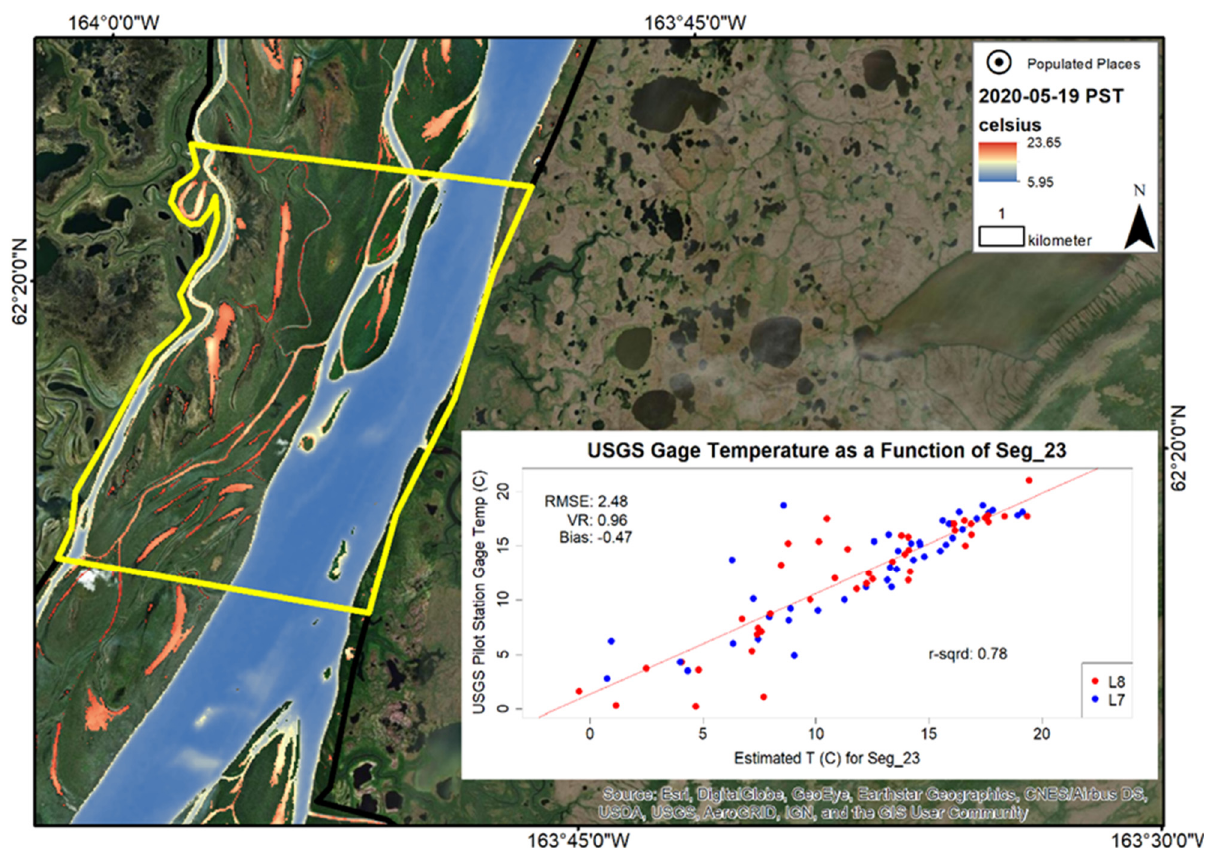
Figure A21. In segment 23, the Yukon River flows in a north northeast direction . The east bank of the river abuts low hills and slight uplands, while the west shore is broken by islands, small sloughs, and channels. The western extreme of the Yukon lies in the Tunurokpak Channel. While this channel is estimated to have cool water temperatures, smaller unnamed sloughs, backwaters, and surface water features can occur with warmer estimated water temperatures. River stage influ- ences the number and size of these features as well as the number and size of islands that exist in the main channel. The pST is 100% with no NoData gaps. Correlation between pST estimates and Pilot Station recordings is good (RMSE = 2.48, r 2 = 0.78.